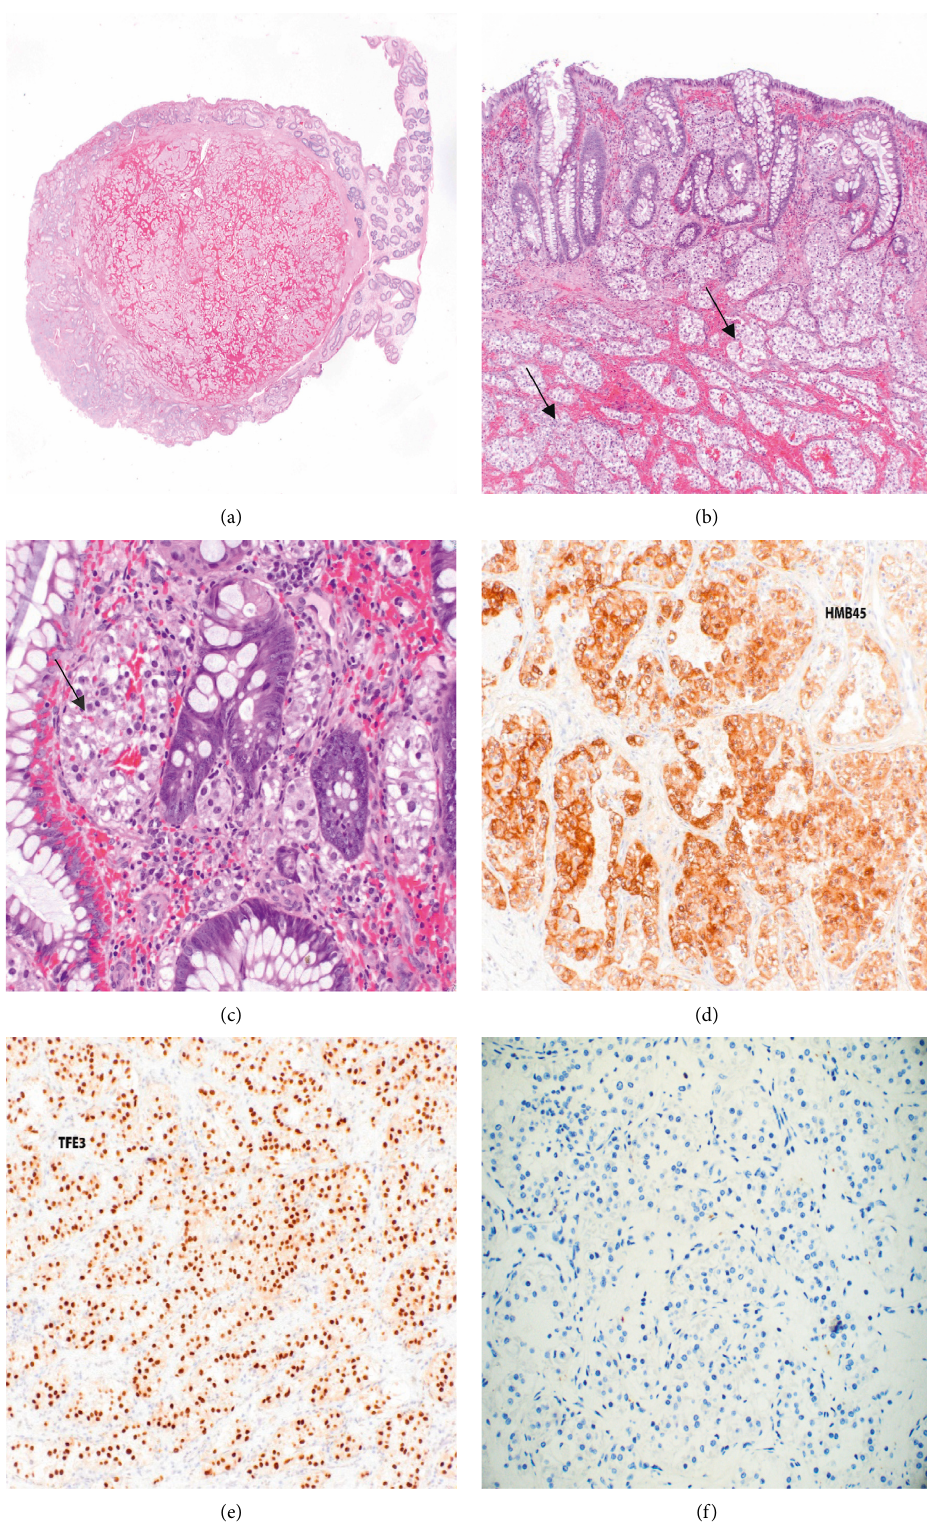
Figure 2: (a) TFE3 rearranged PECOma: low power. (b, c) High-power image of the polyp showing nested lesional cells (arrows) with clear cytoplasm and round nuclei in mucosa and submucosa of colon. (d, e) Lesional cells showed positive immunoreactivity for HMB-45 and TFE3, while (f) negative reactivity for